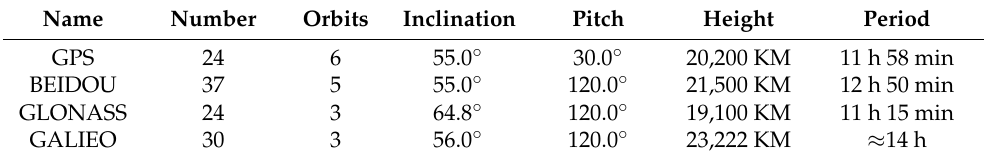
Table 2. Basic parameters of major satellites. From left to right, they represent satellites’ name, numbers, orbit numbers, orbital inclination, satellite orbital pitch, orbit averaged height and averaging